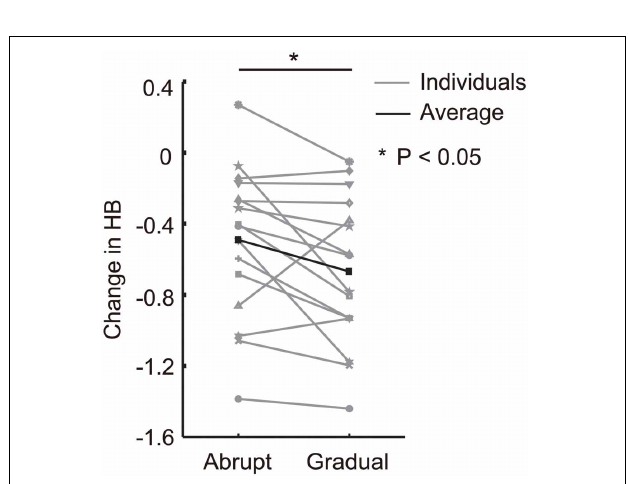
FIGURE 4 | Changes in HB observed from the baseline to the late training blocks during the abrupt and gradual conditions. Gray lines represent the results for each participant. Black line represents the average change in HB for all participants. An asterisk indicate significant differences between conditions ( P < 0 . 05).